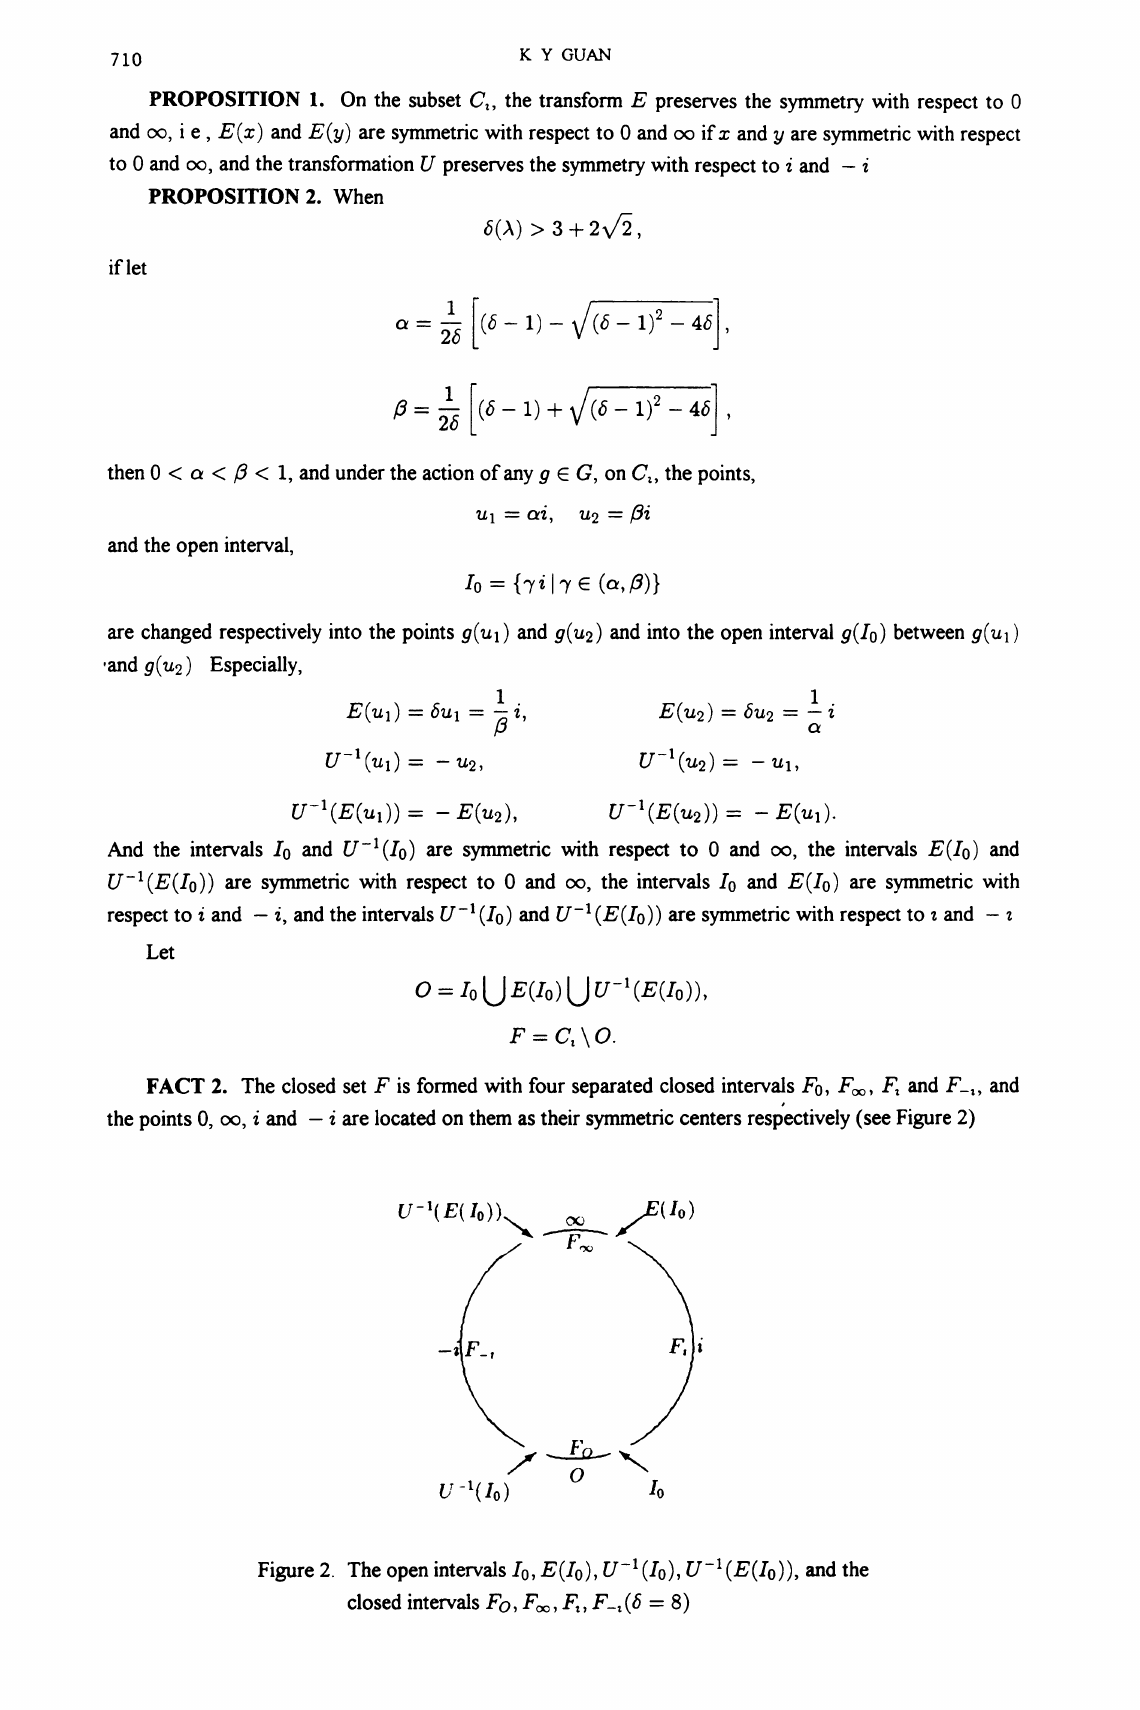
Figure 2. The open intervals Io, E Io ), U Io ), U (E Io ), and